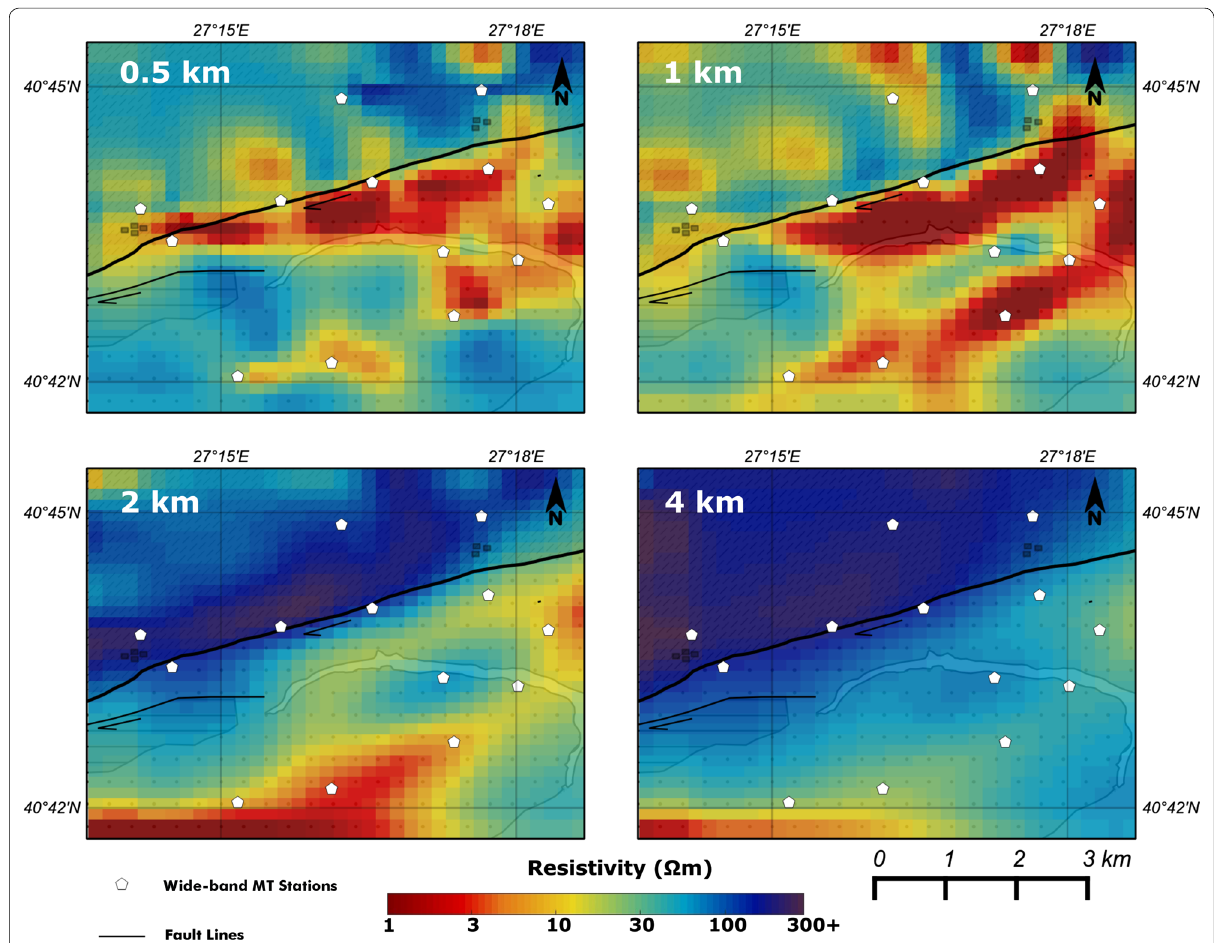
Fig. 5 Resistivity depth sections obtained from the inversion of wide-band magnetotellurics (MT) data for 0.5, 1, 2, and 4 km. The wide-band sta- tions are indicated by white signs . The solid black lines illustrate the major faults in the region. The resistivity color scale is